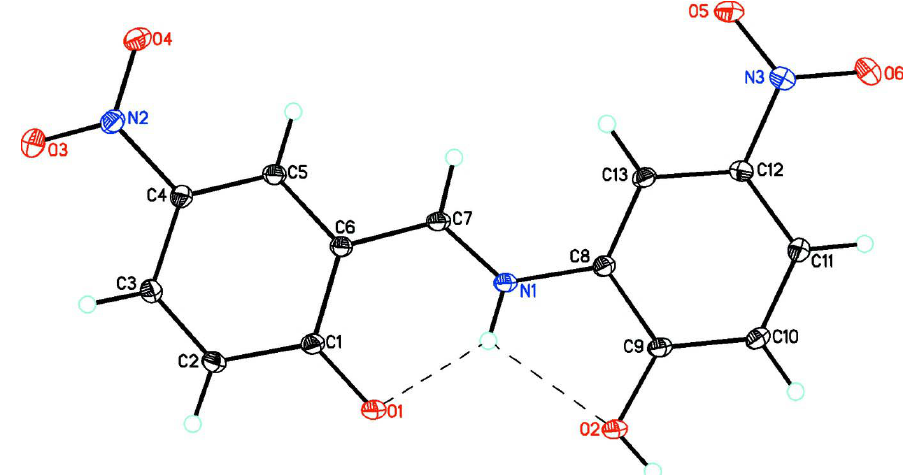
Figure 1 The molecular structure of C ellipsoids. H1O (0.36 (3) occupancy) has been omitted from O1 in the diagram and only the predominant component, H2O (0.64 (3) occupancy), has been shown. Dashed lines indicate intramolecular N–H···O hydrogen